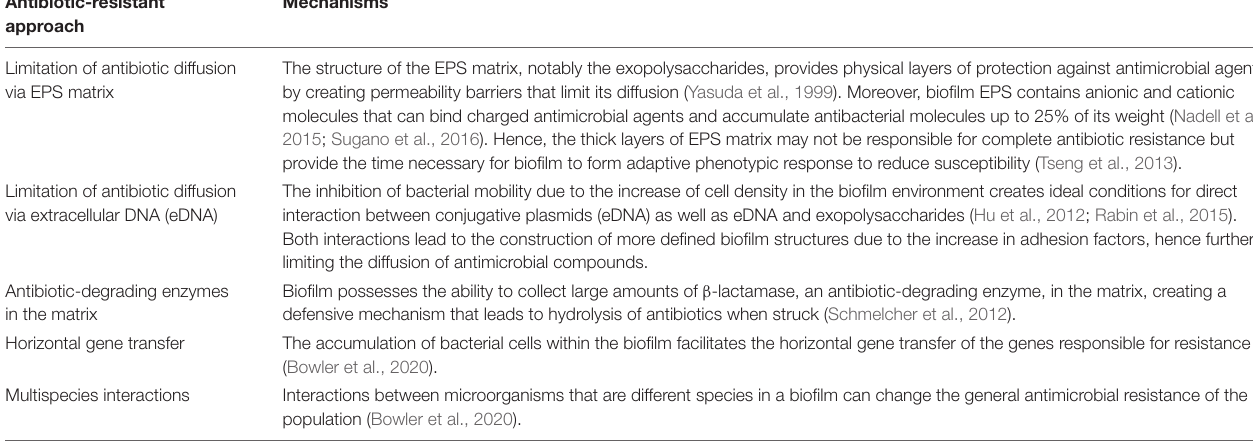
TABLE 1 | Biofilm’s antibiotic-resistant approaches and their mechanisms. Antibiotic-resistant approach